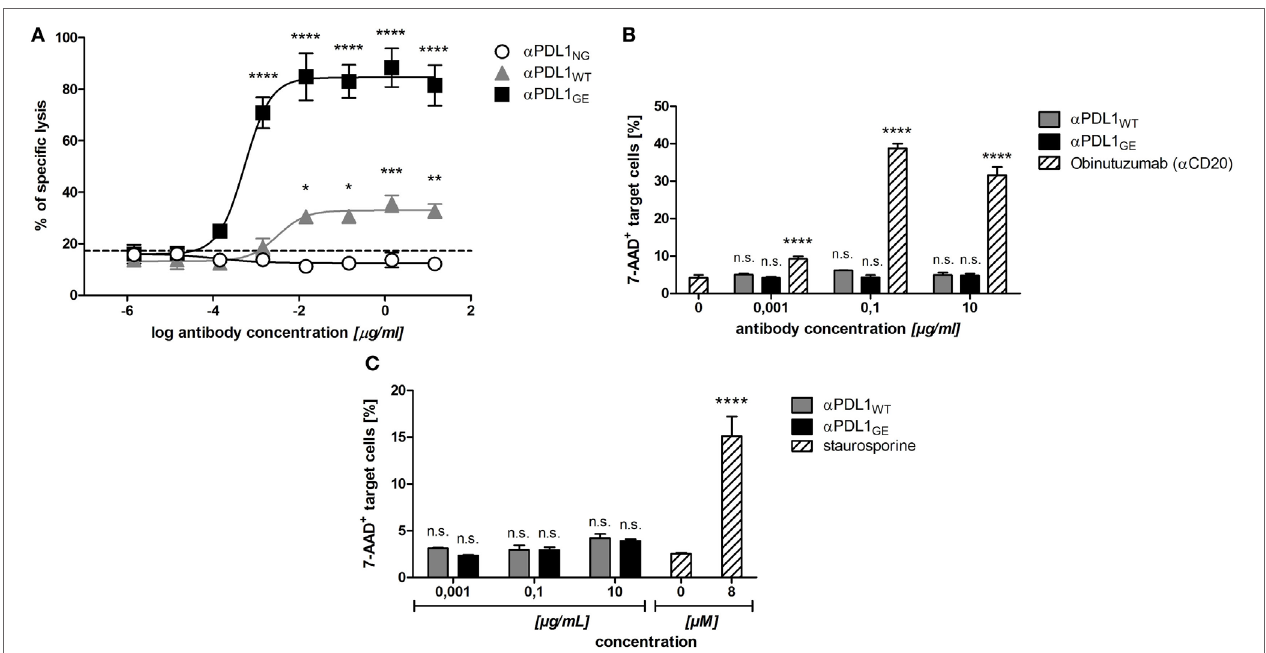
FigUre 3 | Glyco-engineered anti-human programmed death-ligand 1 (PD-L1) antibody induces strongest NK cell-mediated antibody dependent cellular cytotoxicity (ADCC) against PD-L1 + cancer cells, but none against B cells and monocytes. (a) The NK cell line KHYG-1-CD16aV as effector cells was incubated with europium-loaded PD-L1 + DU-145 cancer cells as target cells in an effector to target ratio of 10:1 in the presence of increasing concentrations of α PDL1 NG (white